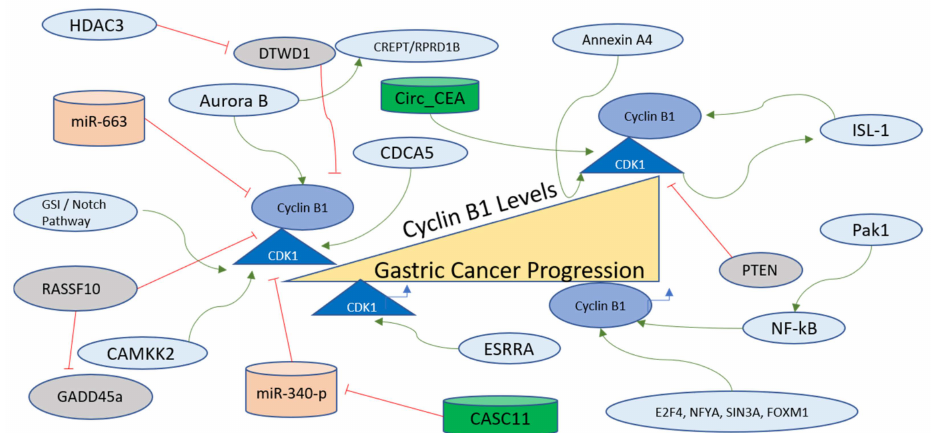
Figure 7. Cyclin B1/CDK1 regulation in gastric cancer progression. The Cyclin B1/CDK1 axis is at the critical conjuncture of G2-M transition and mitotic exit, and is therefore an important component of the cell division pathway. Various factors, including long non-coding RNAs (green), among others (green arrows), activate this axis and are involved in the progression of gastric cancer. The two miRNAs (orange), however, negatively affect the Cyclin B1 and CDK1 in gastric cells, inhibiting their functions and oncogenic properties. Further details of the regulating factors affecting the Cyclin B1/CDK1 axis are described in the main